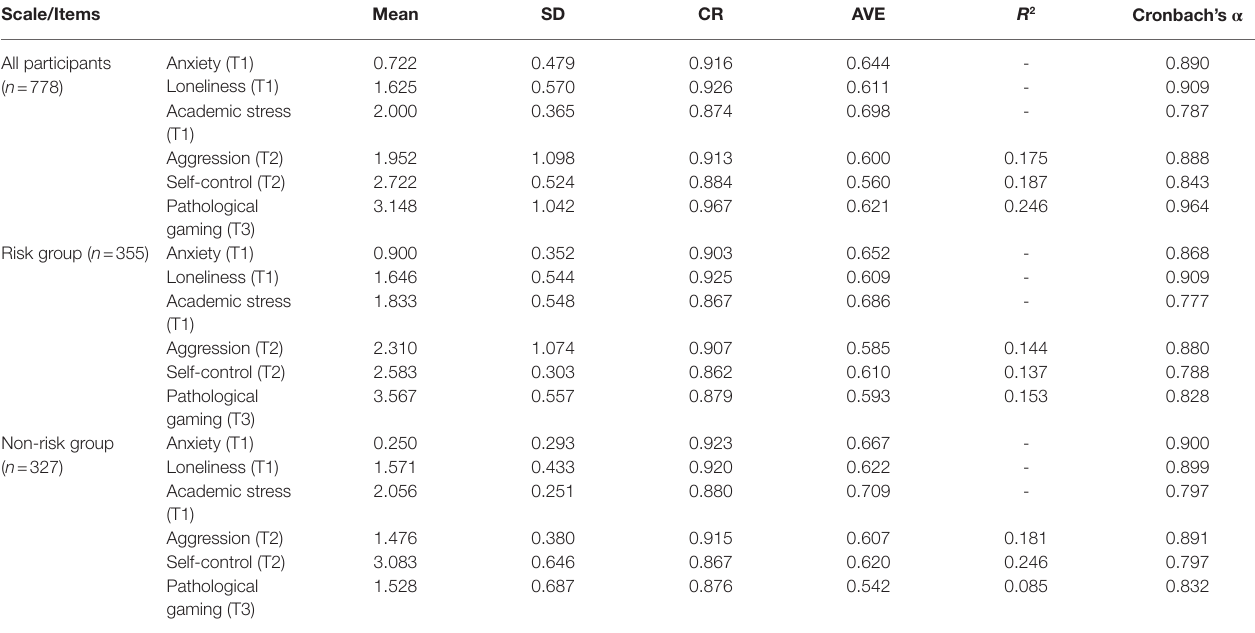
TABLE 3 | Results for the measurement